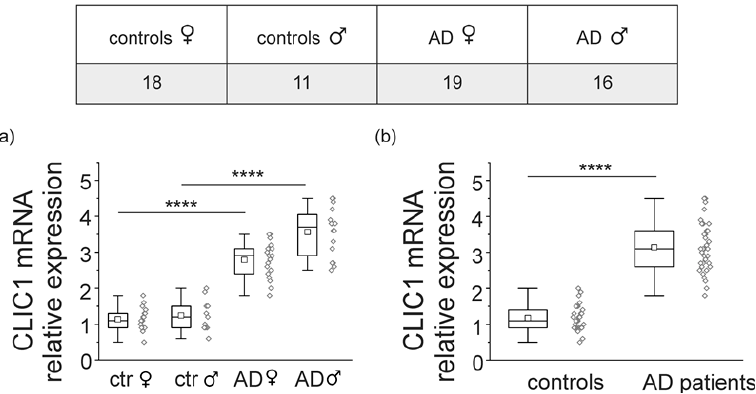
Figure 2. CLIC1 mRNA overexpression in peripheral blood mononuclear cells (PBMCs) from AD patients. ( a ) CLIC1 mRNA relative expression in PBMCs from 18 female and 11 male healthy controls is significantly lower compared to the CLIC1 mRNA level in peripheral blood cells from 19 female